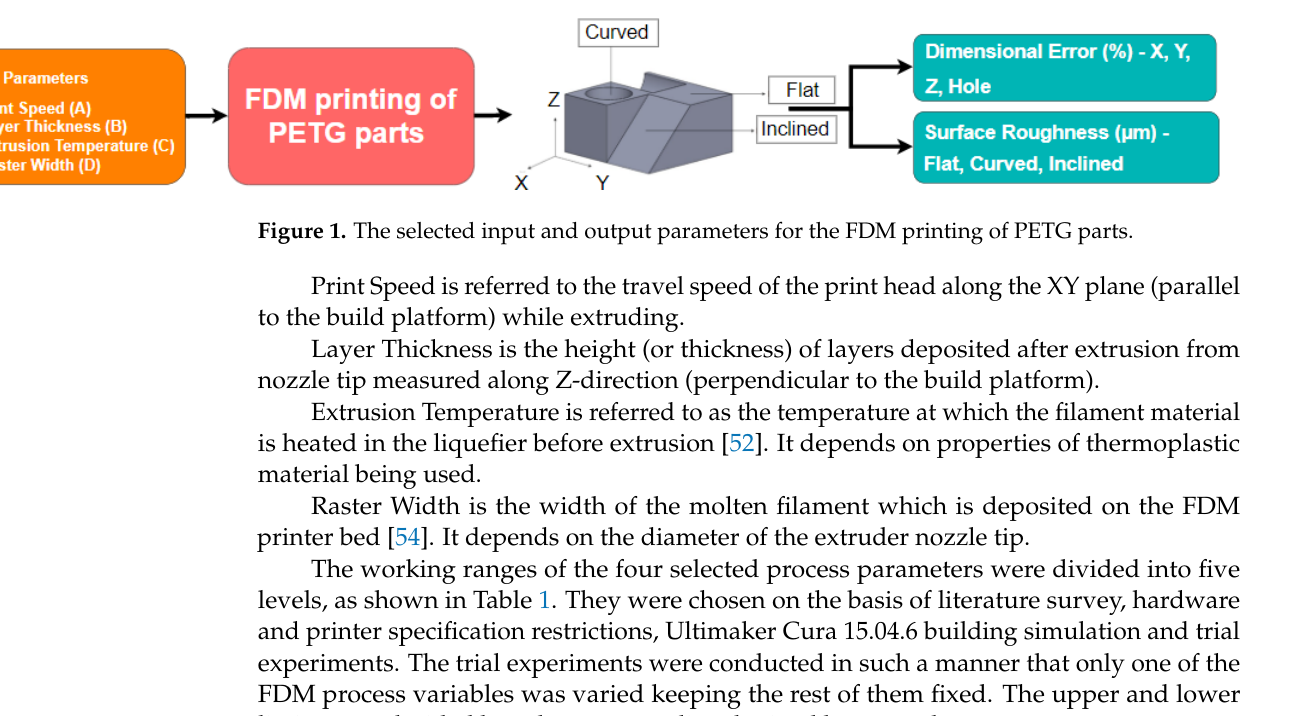
Table 1. Working levels of input parameters.